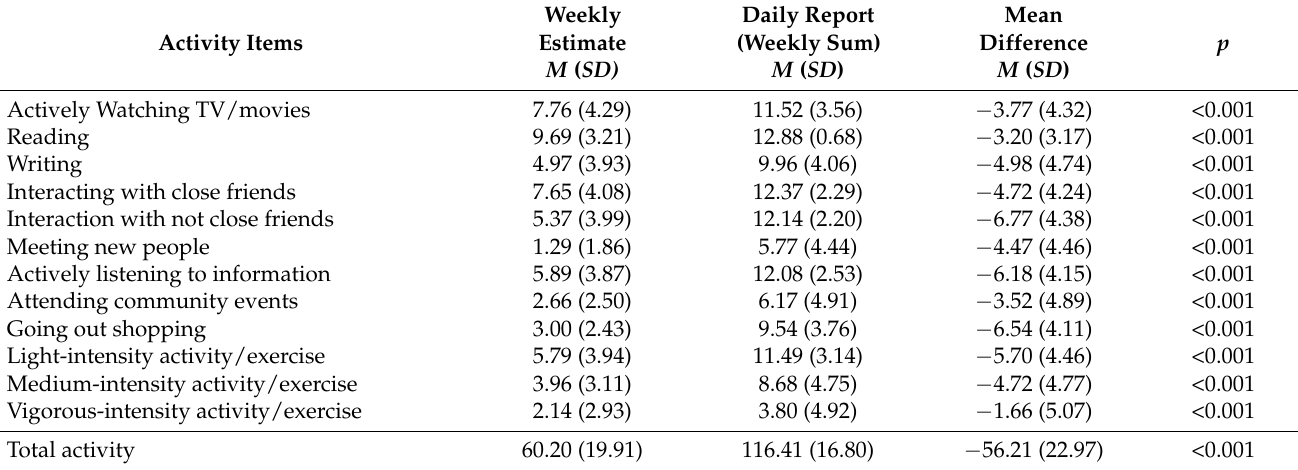
Table 1. ACC Study: Estimated Weekly and Reported Daily Activity (summed over 1 week) for 12 Activity Items